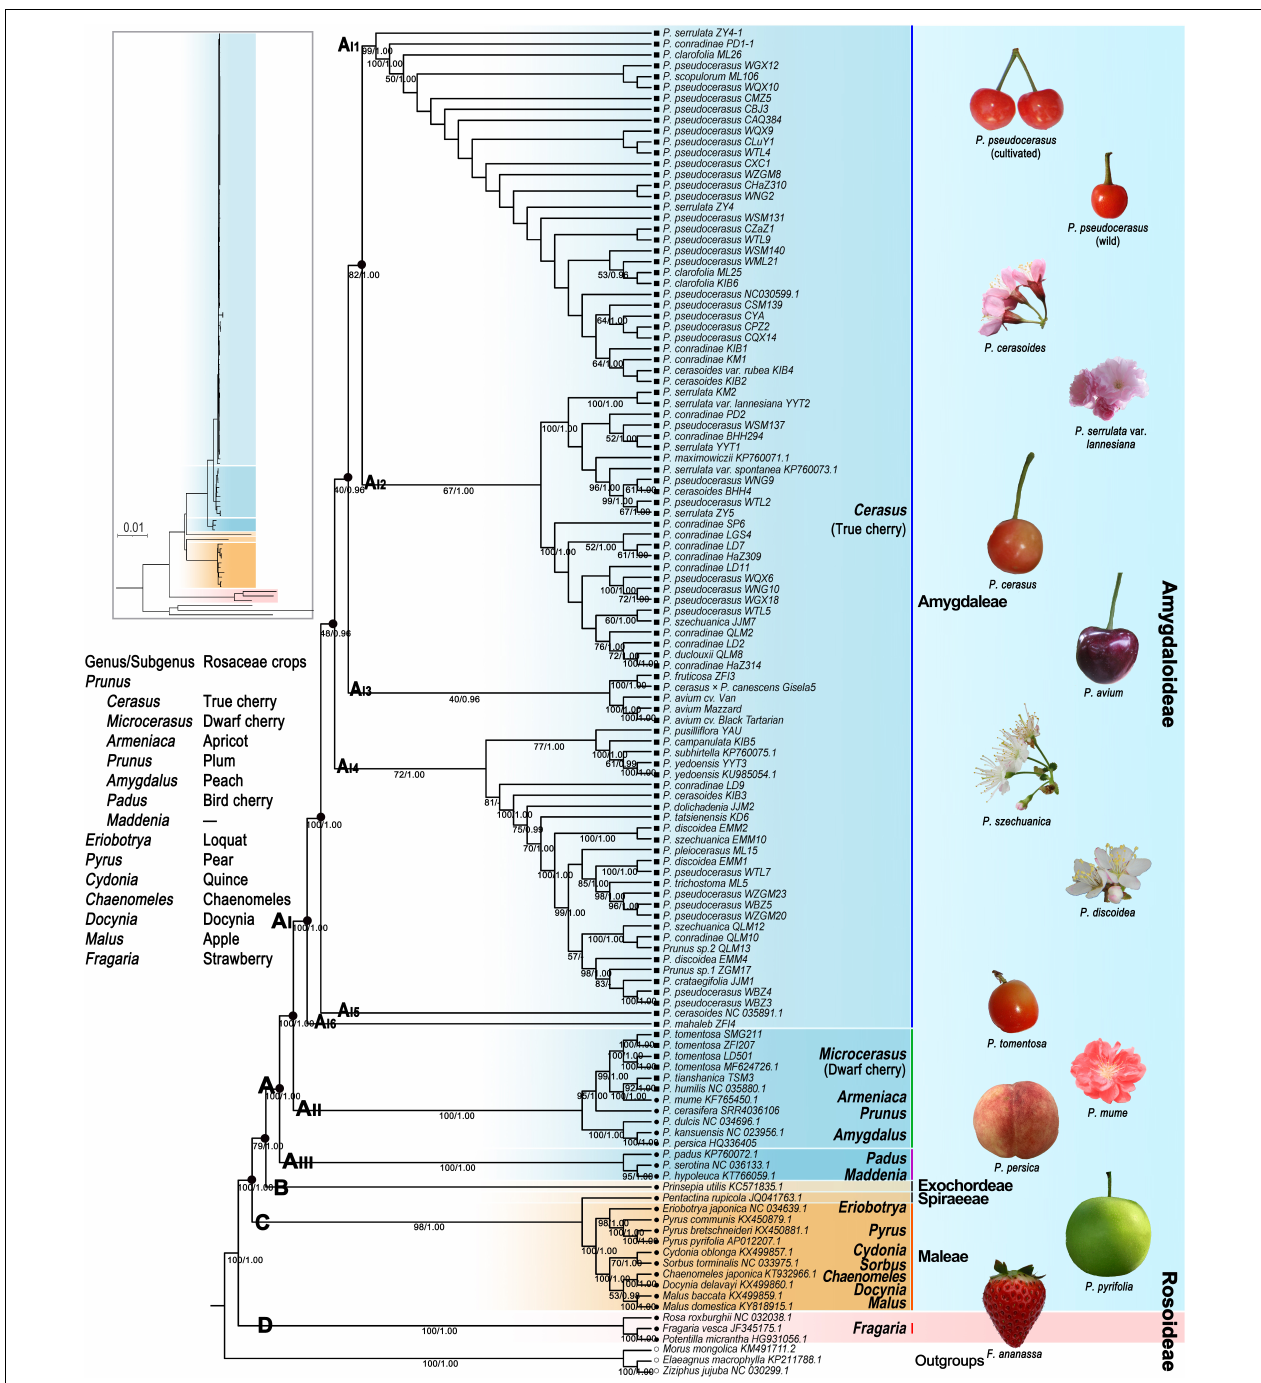
FIGURE 3 | Phylogenetic tree of Rosaceae crops based on the maximum likelihood method under PWGD dataset. Bootstrap (BS)/Bayesian inference (BI) posterior probabilities (PPs) were shown below the branches. PWGD, pruned whole plastome dataset, n = 124.